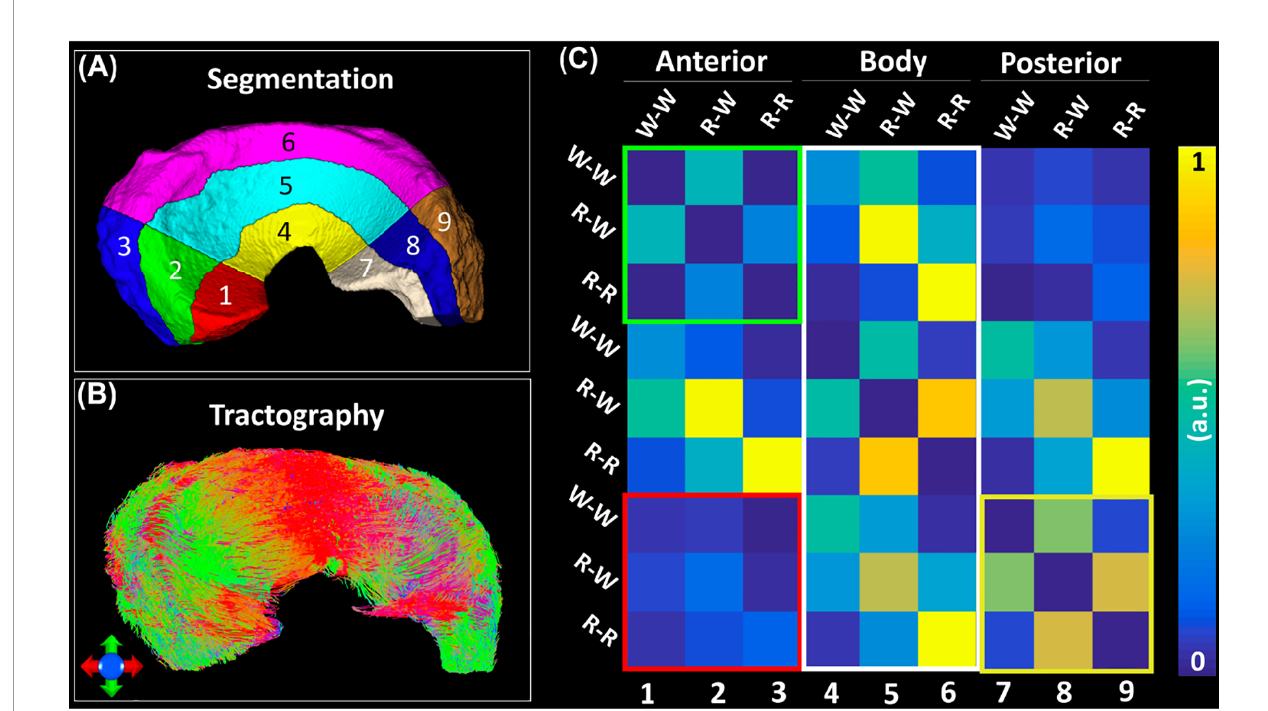
FIGURE 6 | The structural connection heatmap of meniscus (C) obtained by the automatic parcellation (A) and tractography (B)